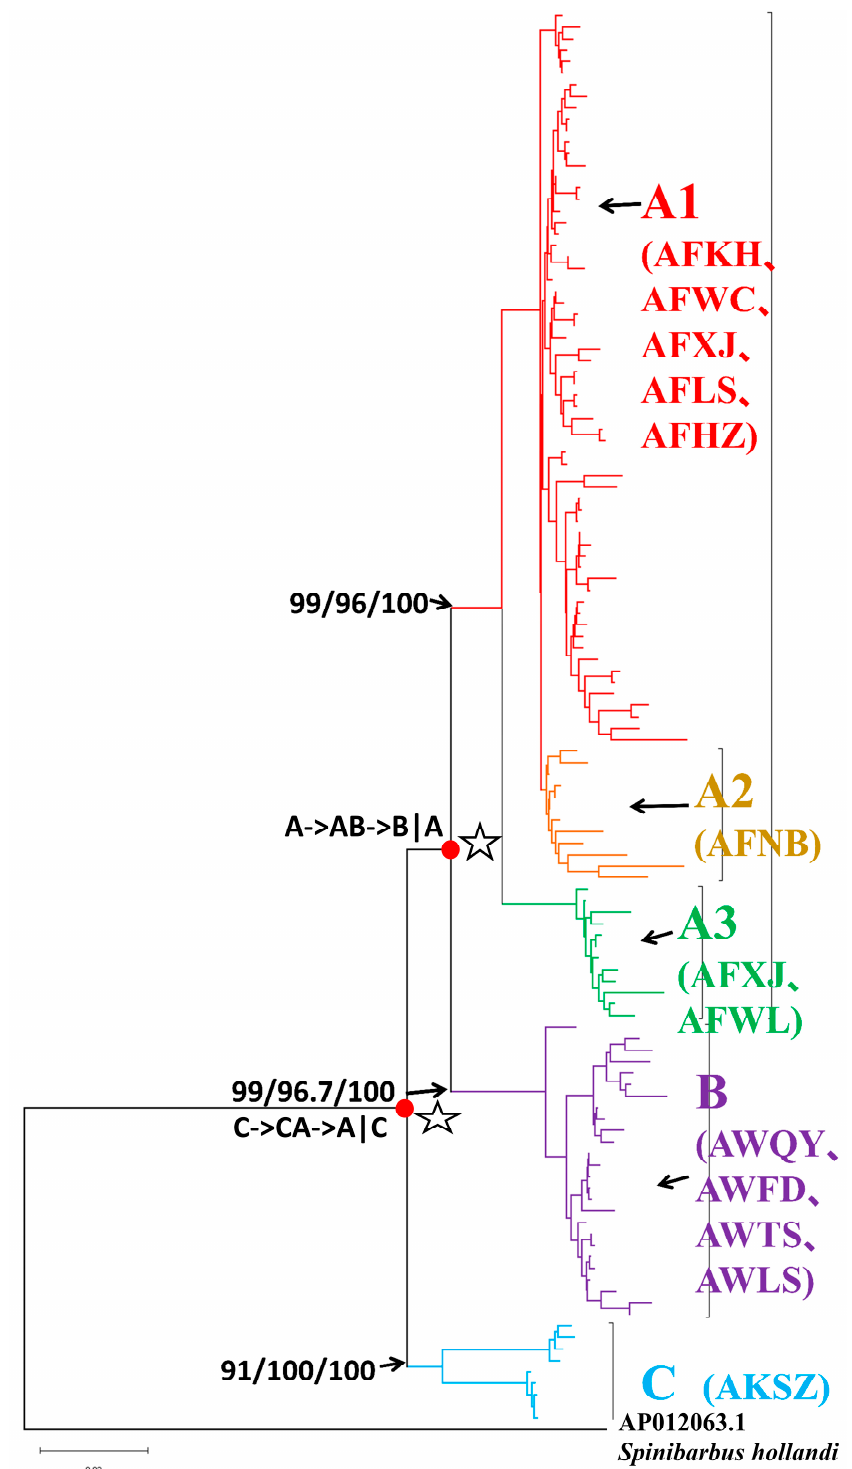
Figure 3. BI tree of genetic relationships based on the mitochondrial cyt b + D-loop region among 12 populations of three Acrossocheilus species using 123 haplotypes. The values above the branches are the posterior probabilities for bootstrap values for the NJ, ML and Bayesian analyses. Spinibarbus hollandi is shown as an outgroup (NCBI accession No. AP012063.1). The results are also presented based on the statistical Bayesian binary MCMC (BBM) method implemented in RASP 3.2. • indicates vicariance events; ☆ indicates dispersal events. A: Northern Zhejiang region; B: Southern Zhejiang region; C: Yangtze River region.